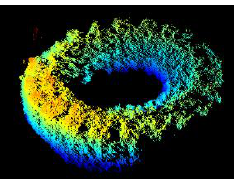
Table 3. Comparison of the two models.